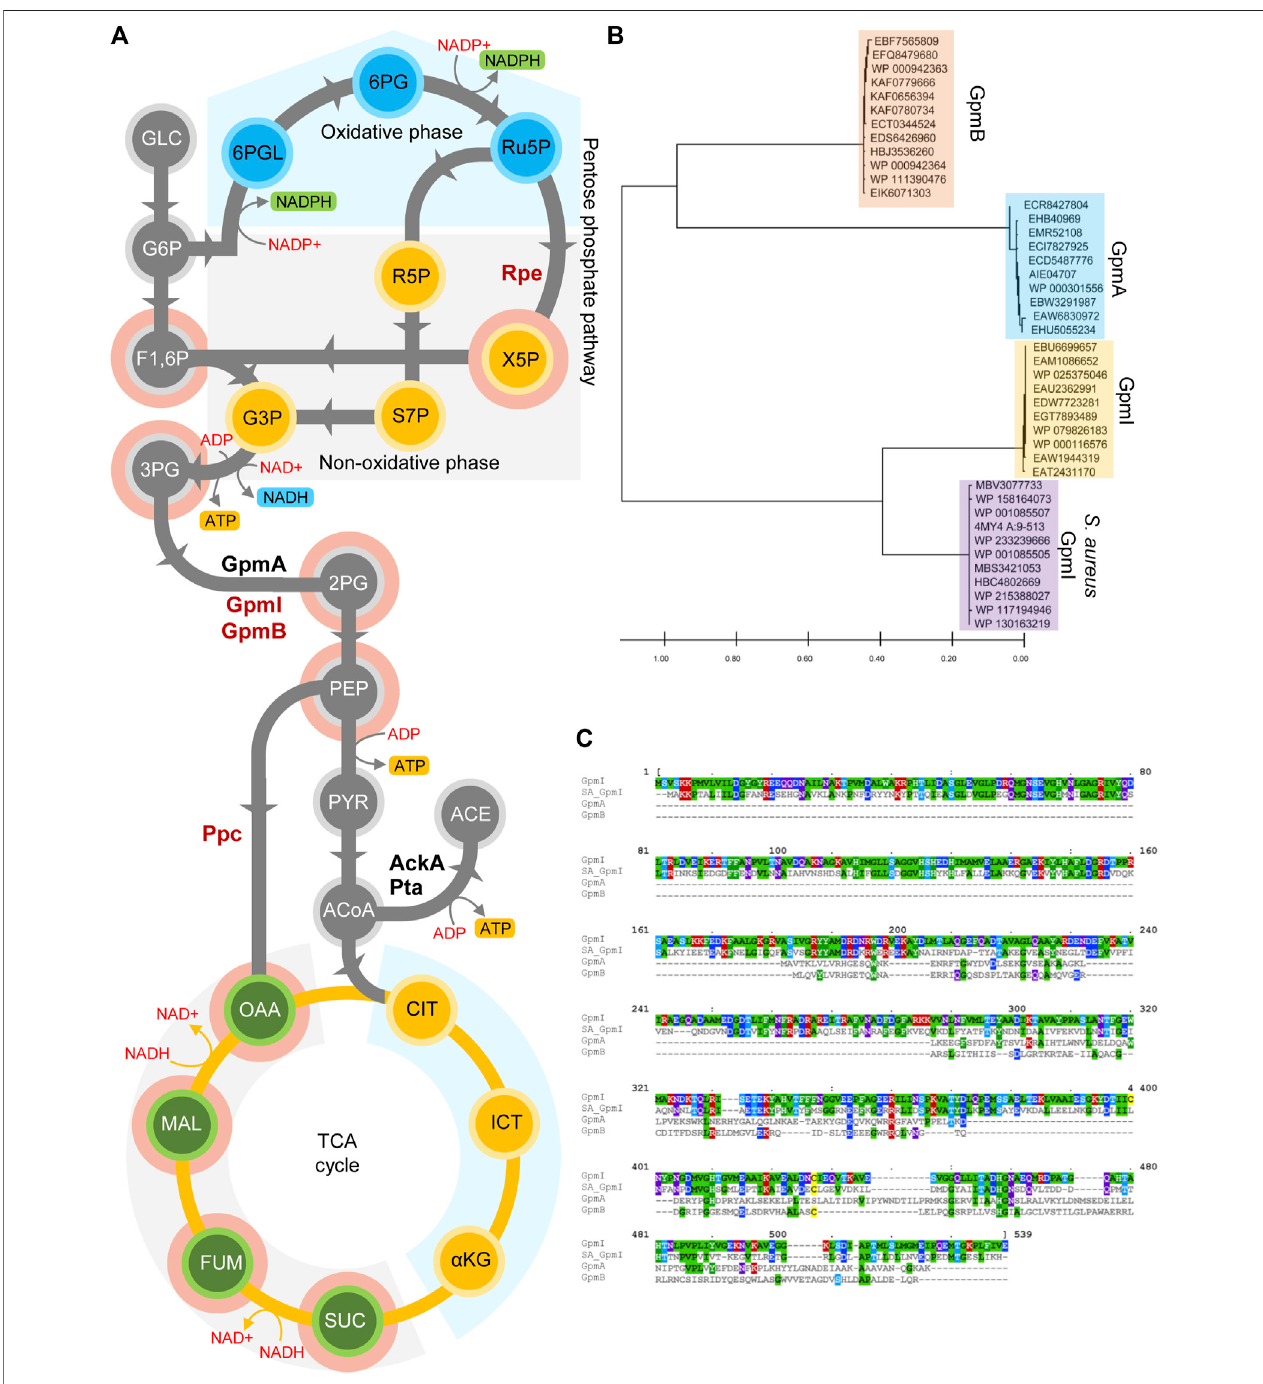
FIGURE 2 | Manganese dependent metabolic adaptations in Salmonella . (A) Schematic representation of central metabolites and enzymes involved in glycolysis and TCA cycle. Enzymes in red are Mn 2+ dependent. Glycolytic conversion of 3PG to 2PG is catalyzed by GpmA, a Mn 2+ -independent protein or its non-homologous isofunctional Mn 2+ -dependent GpmB and GpmI. During oxidative stress induced Mn 2+ limitation, Salmonella utilizes the GpmA isoform to synthesise 2PG. The Mn 2+ - dependentphosphoenolpyruvatecarboxylase(Ppc)shuntsPEPintothereductiveTCAcycle.Ribulose-5-PO 4 ,3-epimerase(Rpe),whichcatalyzestheconversion of ribulose-5PO4 to xylulose-5-PO4, is mismetallated during oxidative stress. As a result, Salmonella metabolism shifts into the production of reductive intermediates of the TCA cycle by Ppc and compromised non-oxidative phase of pentose phosphate pathway. (B) Phylogenetic analysis of Salmonella GpmA, B and I enzymes reveal thatGpmI issimilarto S.aureus GpmI. Differences betweensequencesareestimated bythescaleshownat thebottomofthepanel. (C) Clustalalignmentof Salmonella GpmA(ACY87394.1),GpmB (ACY91834.1) andGpmI(ACY90848.1) with S.aureus GpmI(WP_001085507). Sameschemeasin Figure1D wasfollowedtorepresent the alignment.